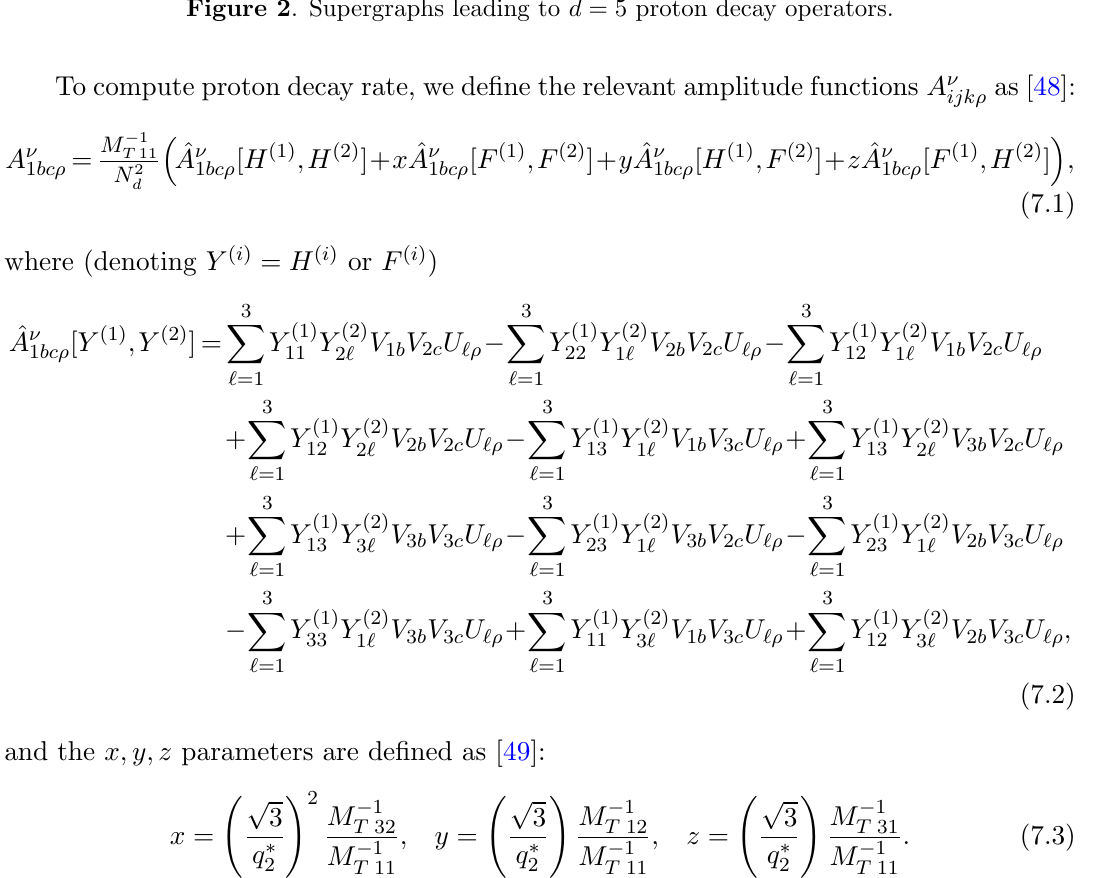
Figure 2 . Supergraphs leading to d = 5 proton decay